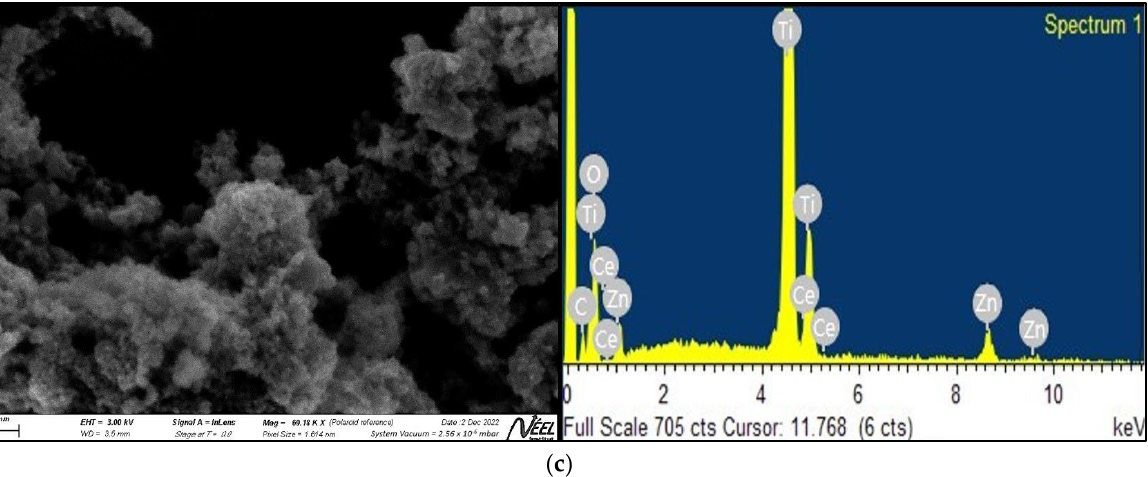
Figure 2. Scanning electron microscopy (SEM) images and energy-dispersive X-ray (EDX) spectra of ( a ) ZTO, ( b ) La/ZTO, and ( c ) Ce/ZTO.